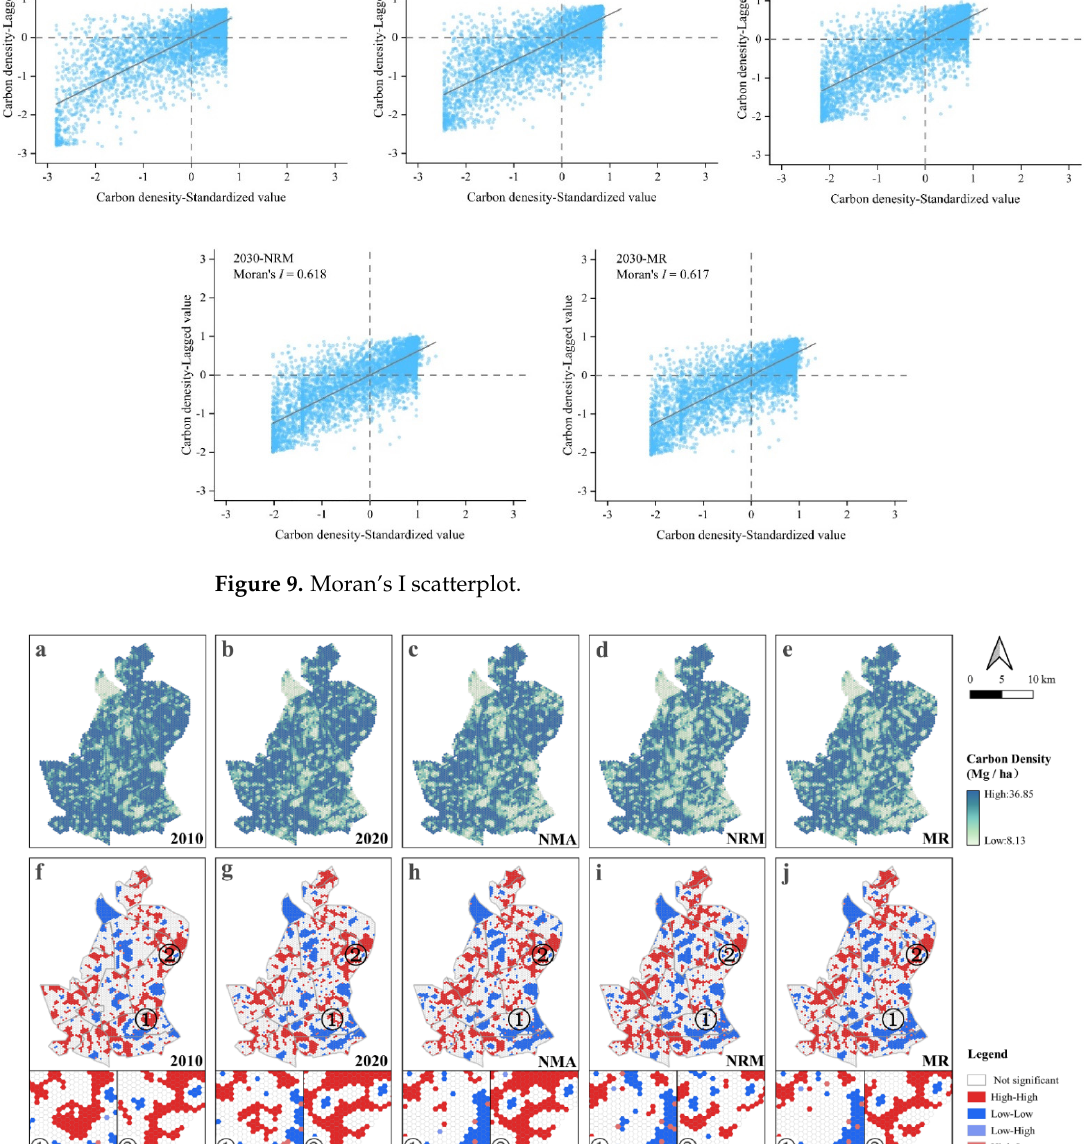
Figure 10. Spatial analysis of carbon storage: ( a – e ) carbon density; ( f – j ) LISA cluster map.